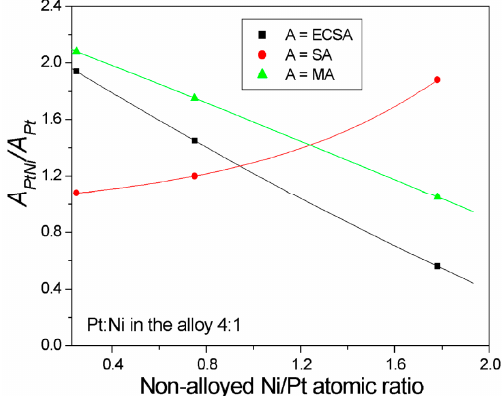
Figure 3. Dependence of the ( A Pt-Ni /A Pt ) ratios ( A = ECSA, SA and MA ) of graphene supported Pt-Ni catalysts on non-alloyed Ni content, at a Pt:Ni atomic ratio in the alloy of 4:1. Data from Reference [42].